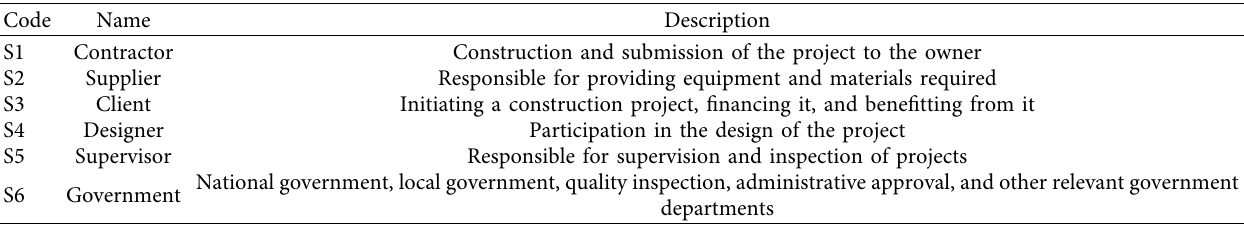
Table 3: Stakeholder identification